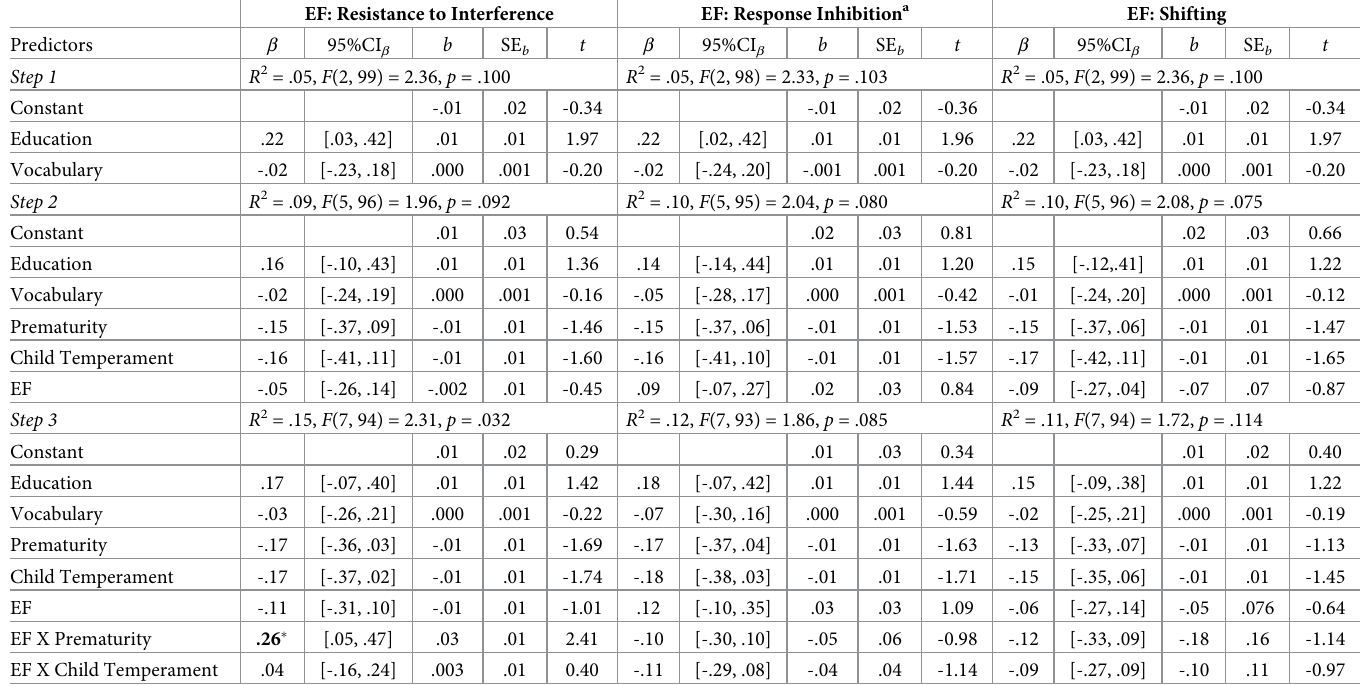
Table 4. Regression analyses for testing executive functions, prematurity, and child temperament in predicting nonattuned mind-mindedness. EF: Resistance to Interference EF: Response Inhibition a EF: Shifting